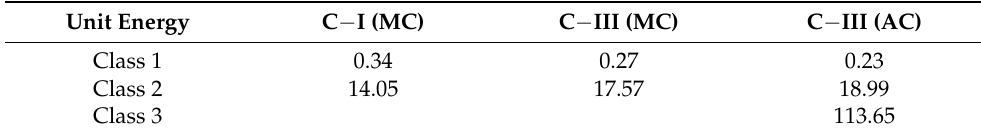
Table 4. The unit energy values.